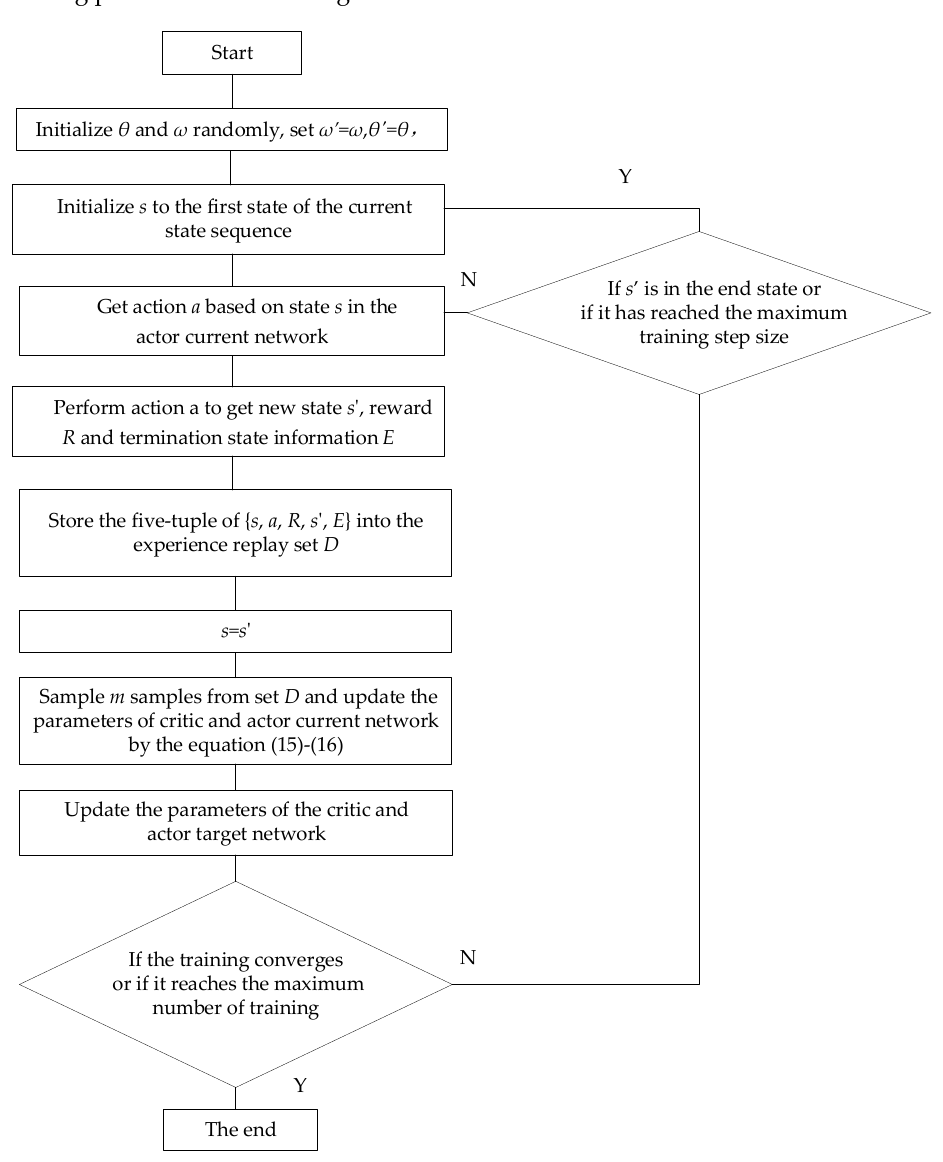
Figure 5. Structure of the islandeded microgrid.